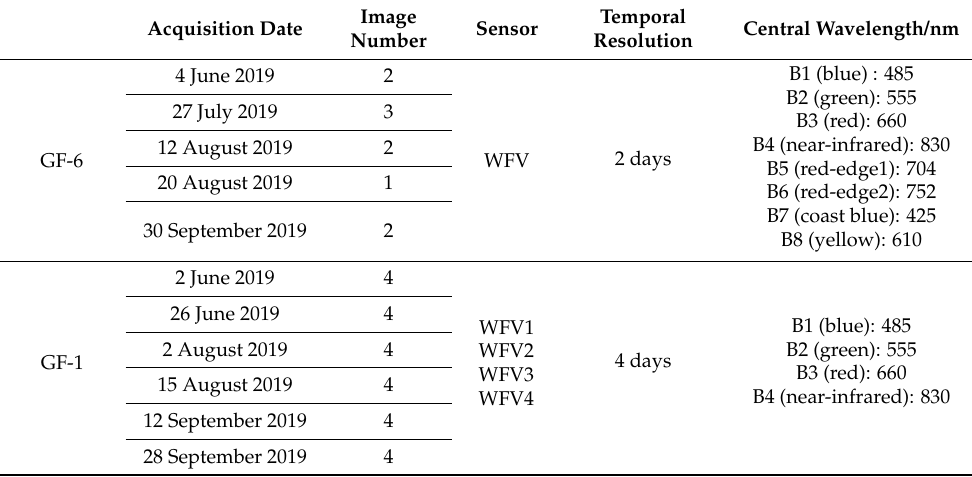
Table 1. The information of GF-6 wide-field view (WFV) and GF-1 WFV.